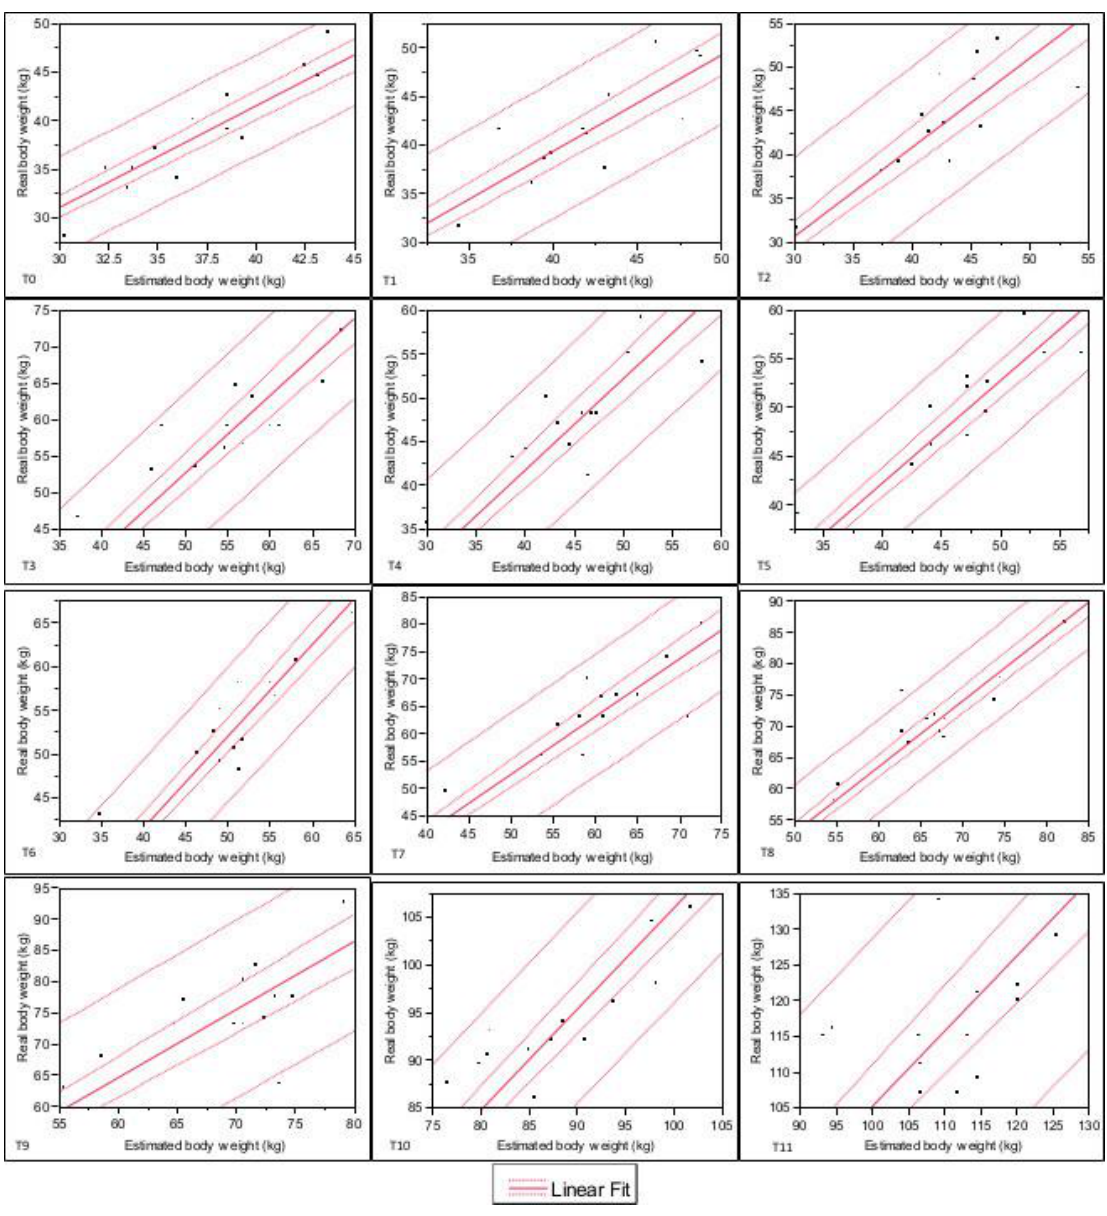
Figure 1. Confidence interval regarding ship between real body weight and estimated body weight investigated from T0 to T11. Internal dashed lines = Prediction lines. External dashed lines = Confidence lines. Legend: T0: at birth, T1: 7 days old, T2: 14 days old, T3: 21 days old, T4: 28 days old, T5: 35 days old, T6: 42 days old, T7: 49 days old, T8: 56 days old, T9: 2 months old, T10: 3 months old, T11: 4 months old.